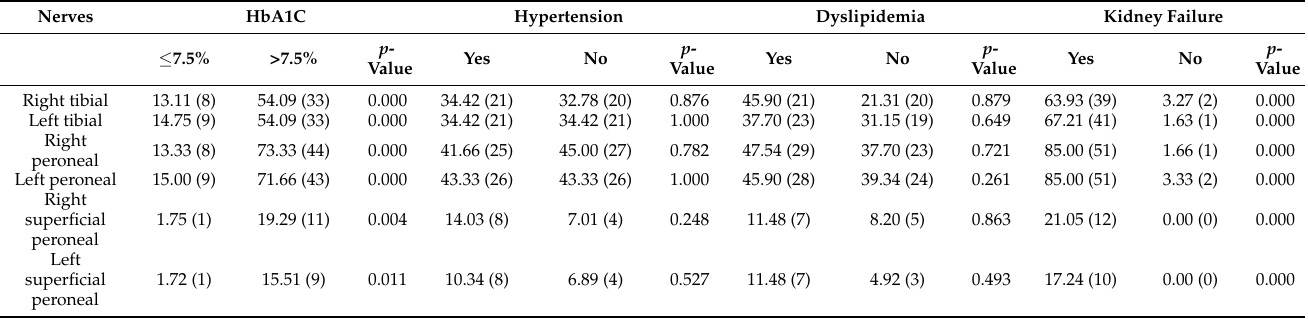
Table 8. Relationship between the rate of nerve damage with HbA1c, hypertension, and kidney